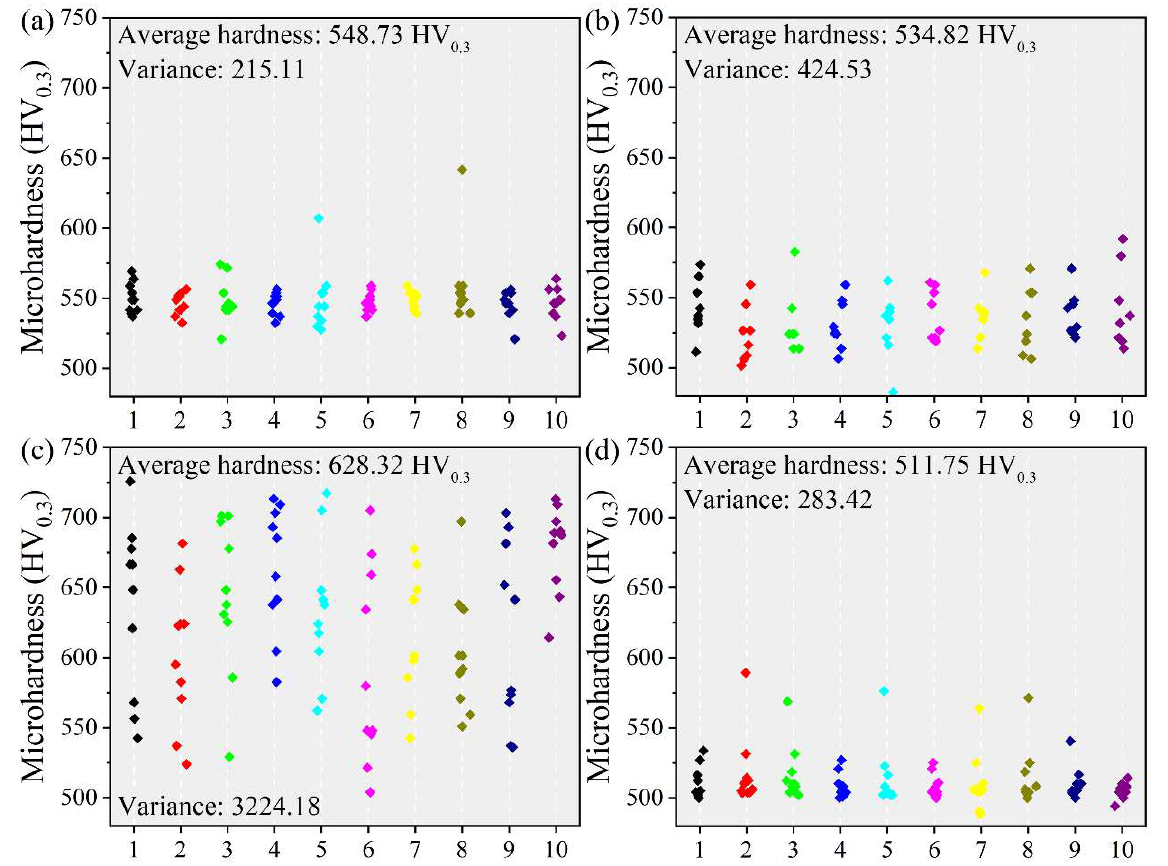
Figure 6. Micro-hardness results of the AlCoCrFeNi components before and after high-temperature treatment: ( a ) as-fabricated; heat-treated at ( b ) 600 °C; ( c ) 800 °C; and ( d ) 1000 °C.